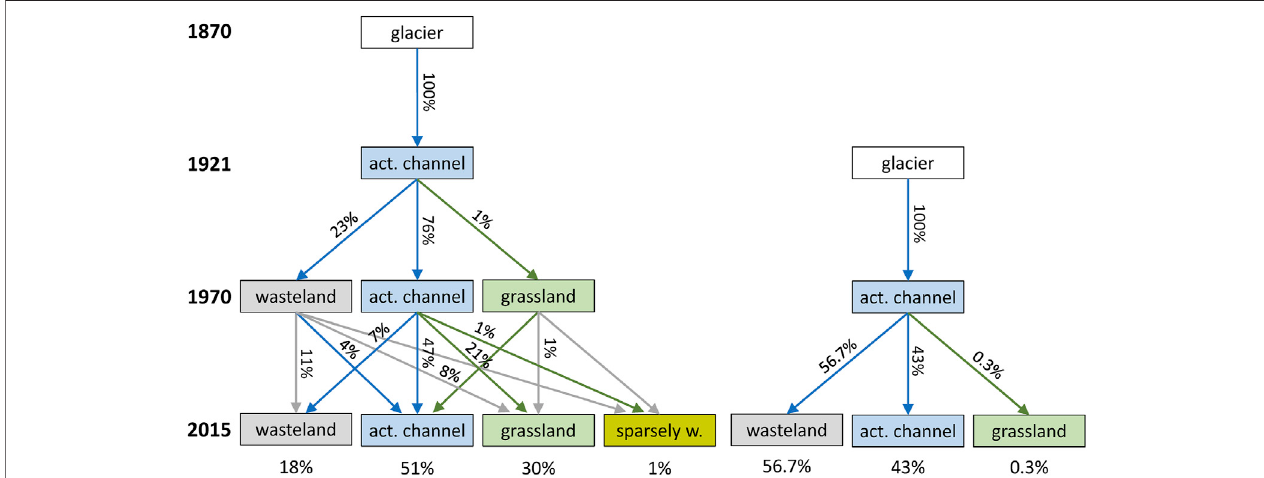
FIGURE9| Biogeomorphictrajectoriesofthe fl uvialcorridorsintheproglacialarea(deglaciatedareabetween1864and 2015):glaciatedareas andwasteland that developed into active channels between 1870 and 2015 (left) and those that started later in/after 1921 (right) . Area proportions (percent cover) < 0.1% are not labelled (act. channel (cid:1) active channel (water surface + unvegetated fl uvial sediments), sparsely w. (cid:1) sparsely wooded (krumholz); blue arrows: changes as part of the geomorphic phase of channel evolution; green arrows: pioneer/biogeomorphic phase; grey arrows: terrestrial processes).